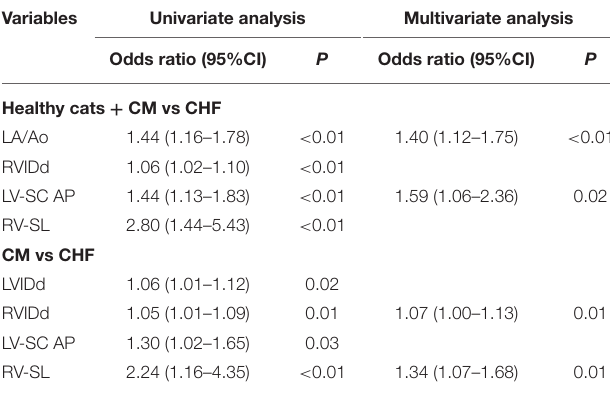
TABLE 3 | Significant variables in the logistic regression